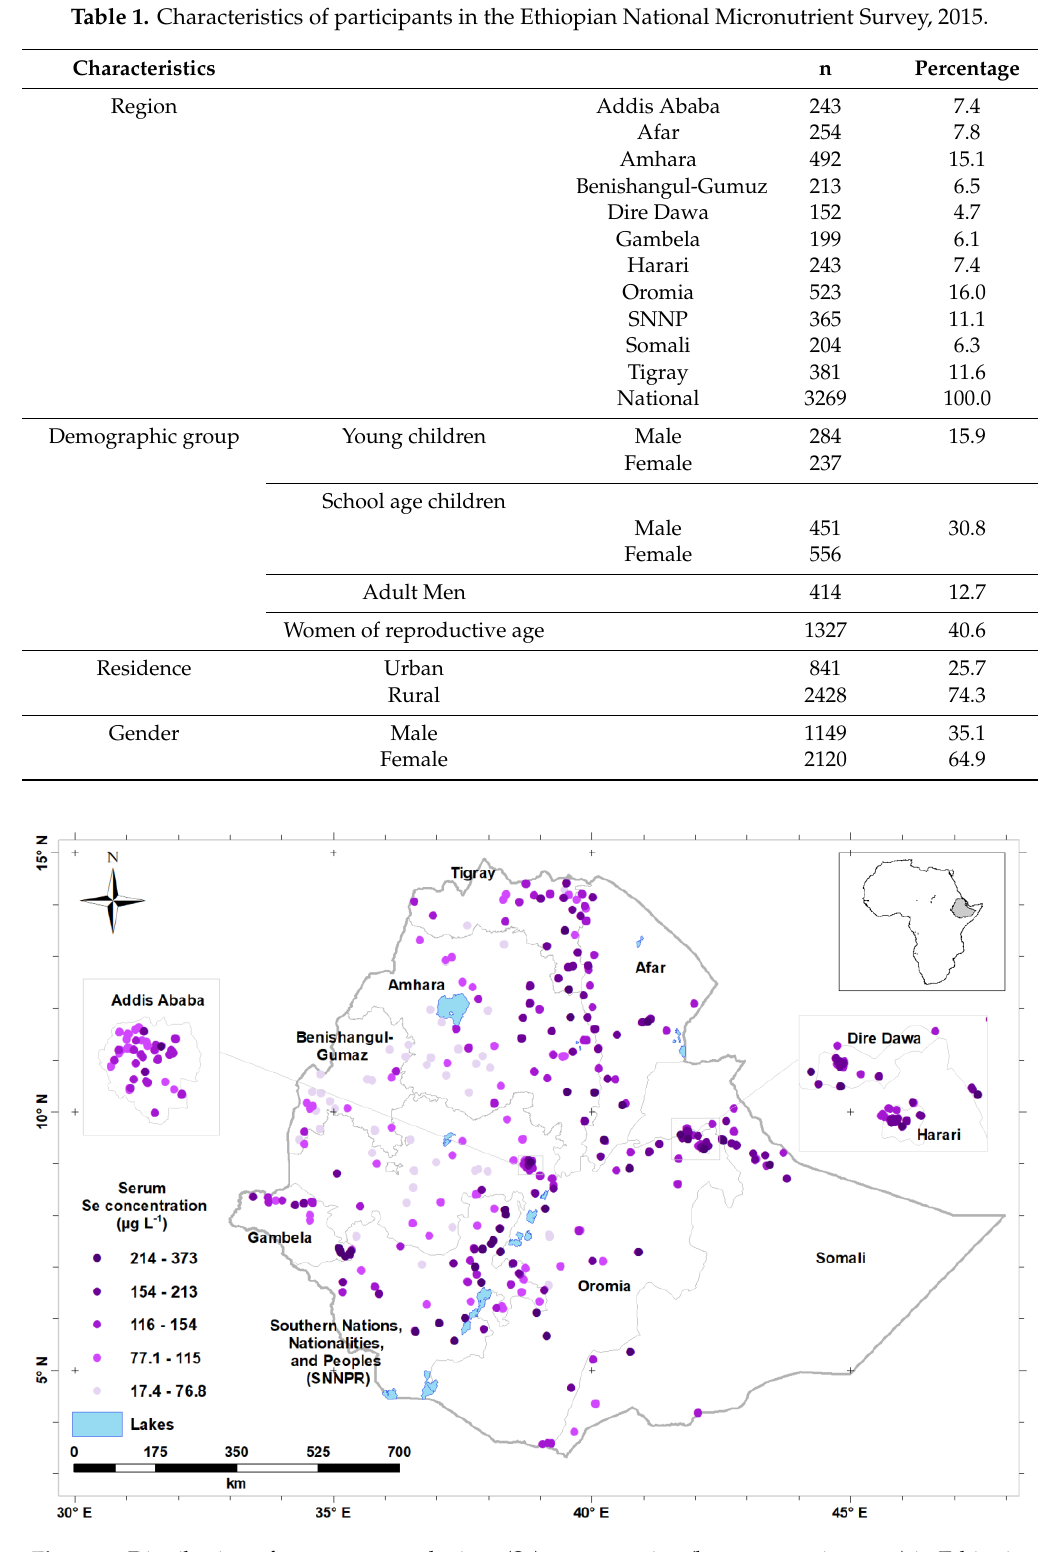
Table 1. Characteristics of participants in the Ethiopian National Micronutrient Survey, 2015.